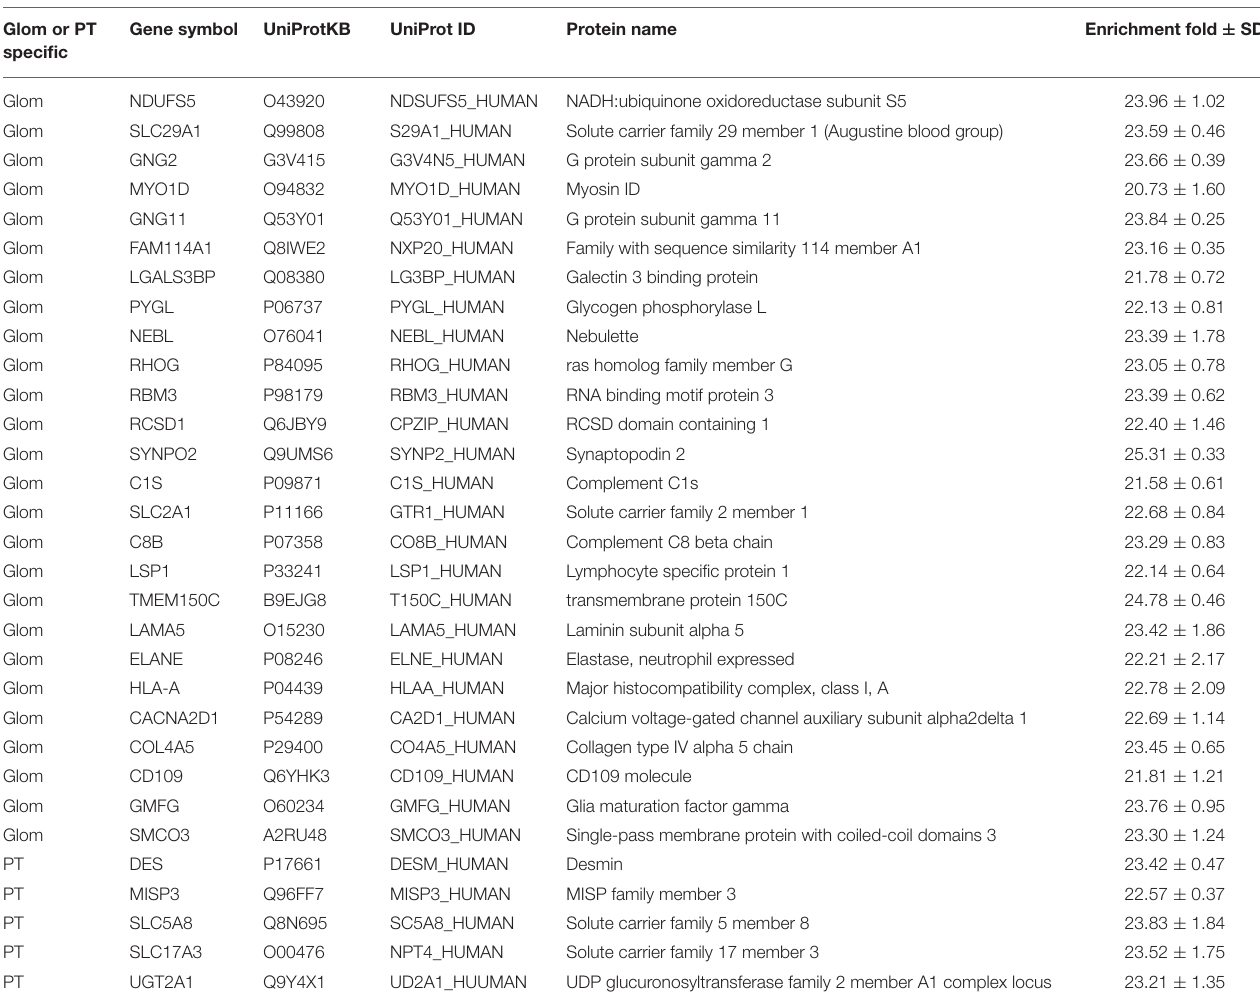
TABLE 1 | Proteins enriched in glomerular and proximal tubular cells identified by nscProteomics. Glom or PT